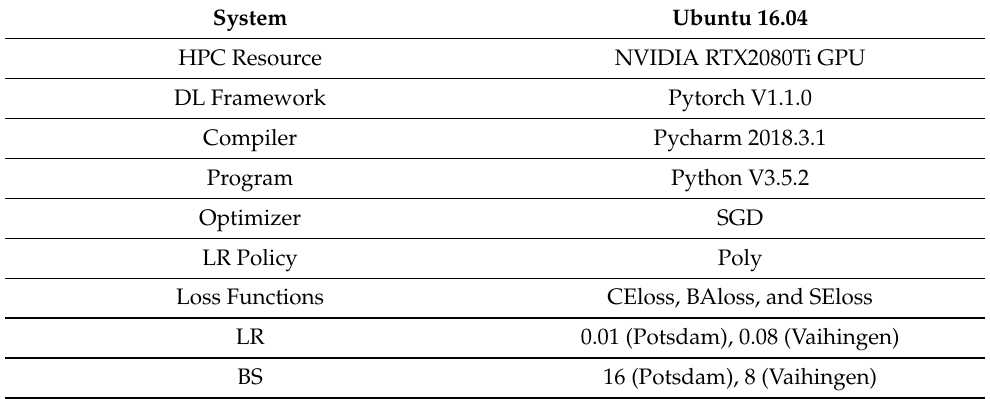
Table 2. Experiment